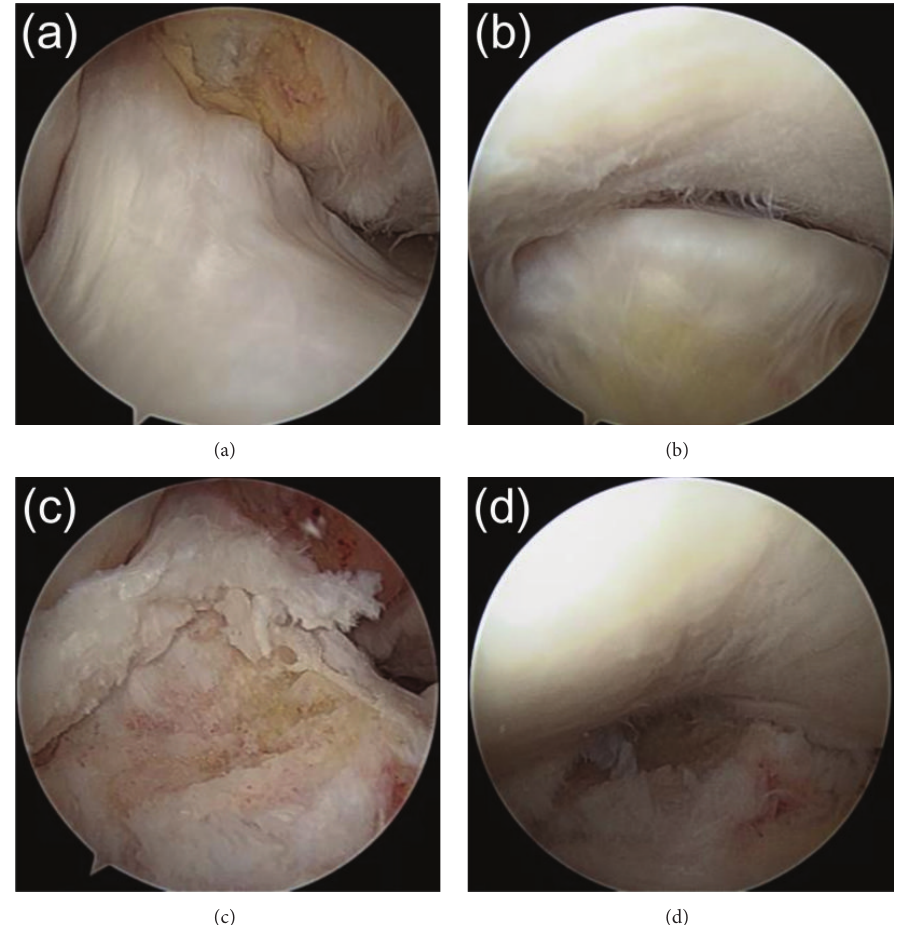
Figure 5: (a, b) Preoperative arthroscopic results, showing that (a) the parenchymal fibers of the anterior cruciate ligament (ACL) were normal, whereas (b) the avulsed fragment impinged on the femoral intercondylar notch as the knee was extended, limiting extension. (c, d) Arthroscopy after debridement, showing that (c) the anterior region of the avulsed fragment was shaved, the posterior region of the ACL attachment site of the tibia was conserved, and the tension of the ACL parenchyma was retained. (d) Excavation of the anterior region of the avulsed fragment resolved the limitation of knee